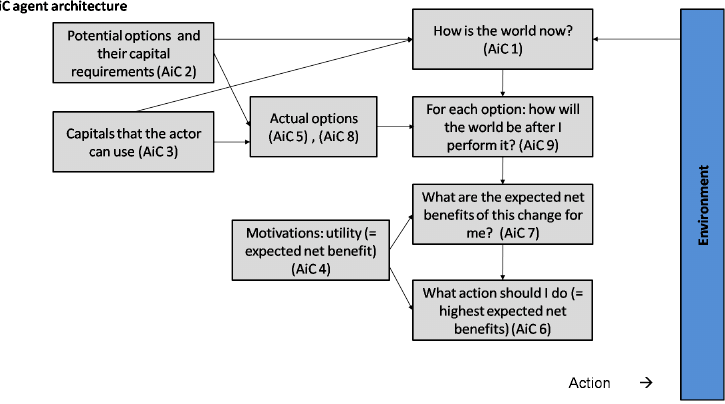
Figure 6. Adaptation of AiC framework to an agent architecture based on the